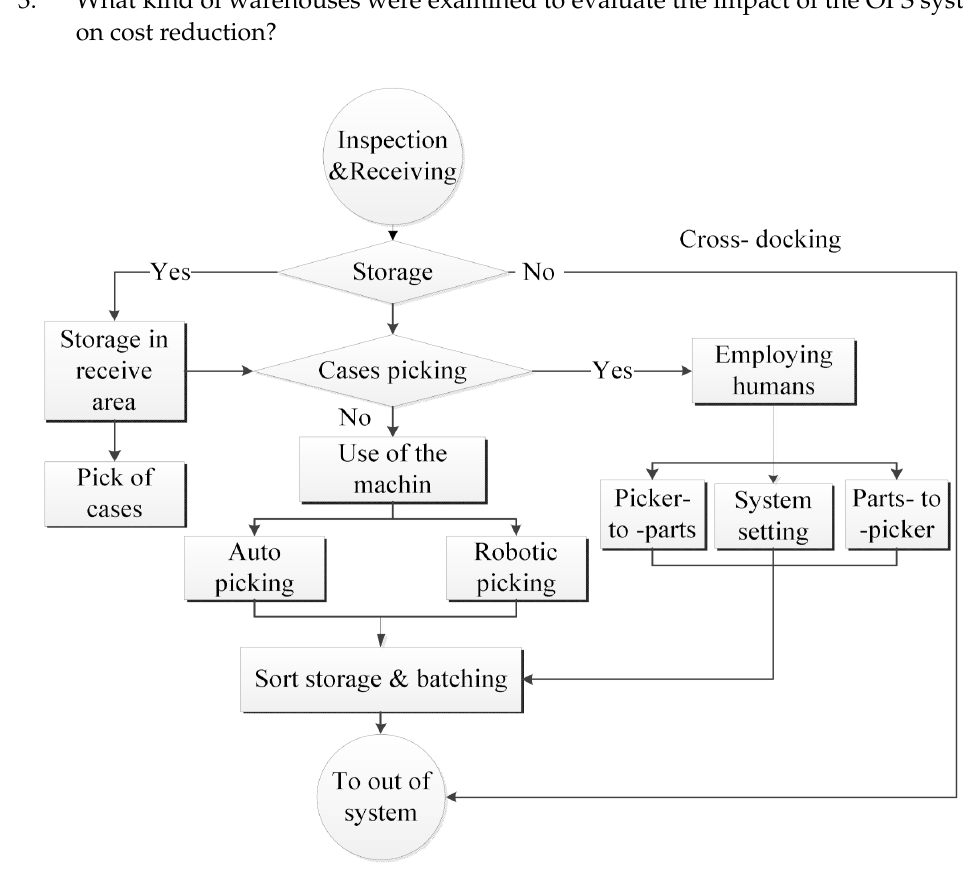
Figure 1. Process map of the picking operation